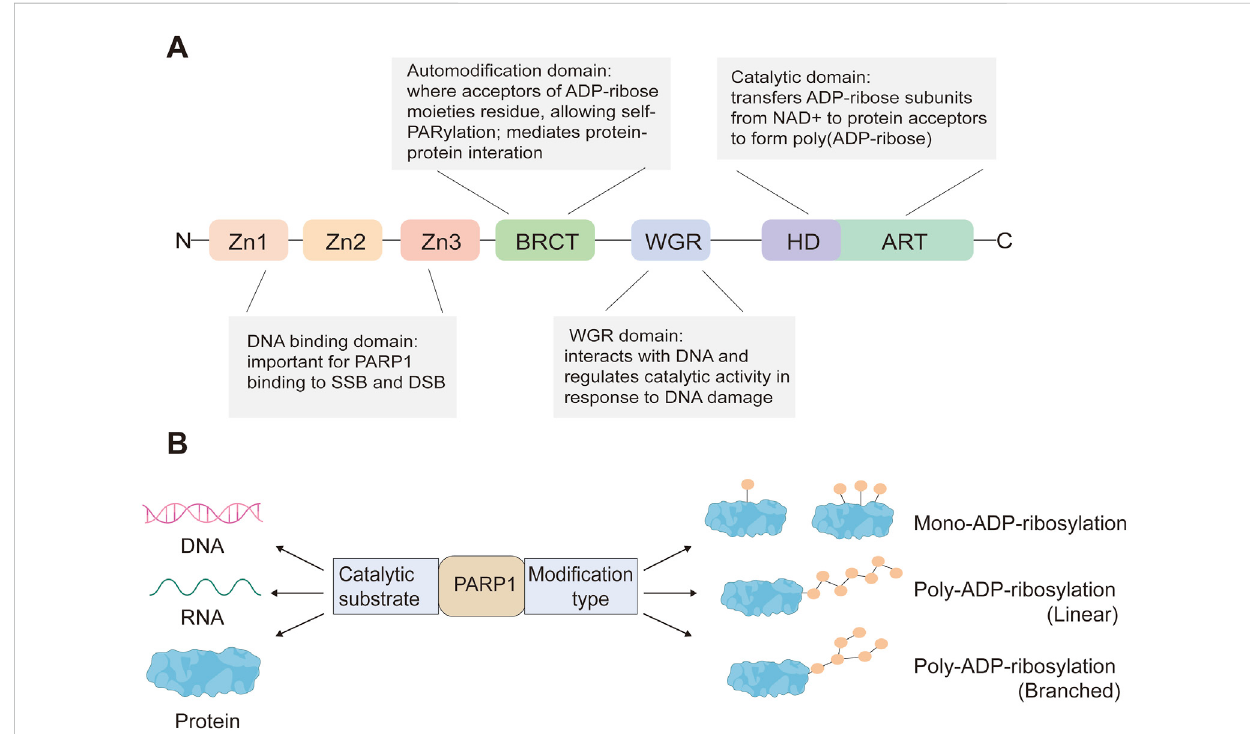
FIGURE 1 PARP1 protein domains (A) and PARP1-mediated ADP-ribosylation modi fi cation types of its substrates (B)